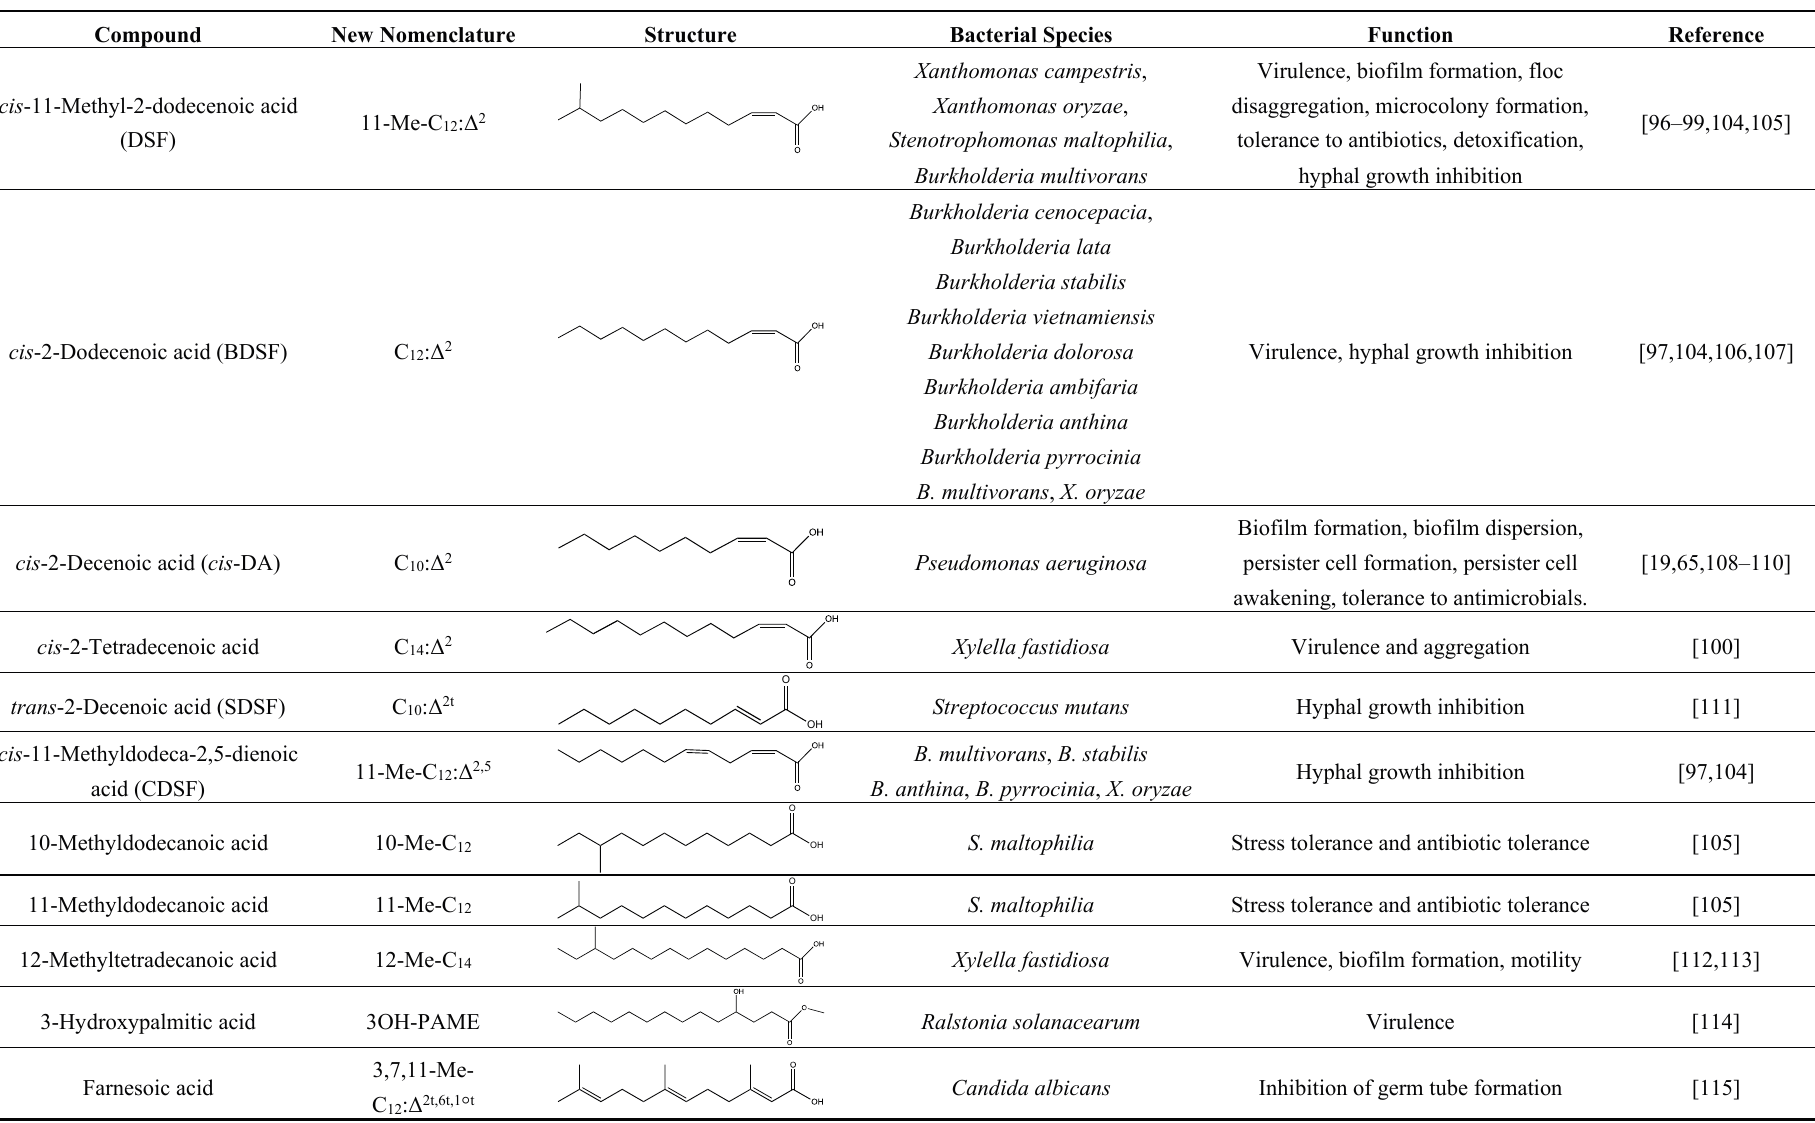
Table 1. Fatty acid signaling molecules with known functions in the various